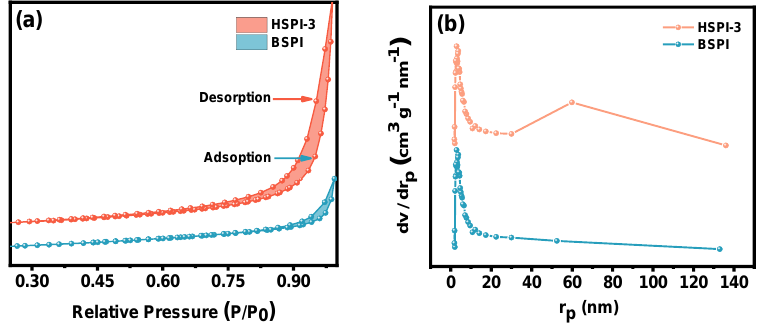
Figure 6. ( a ) Nitrogen adsorption–desorption analysis and ( b ) BJH plot for pore size distribution of BSPI and HSPI-3 composites.